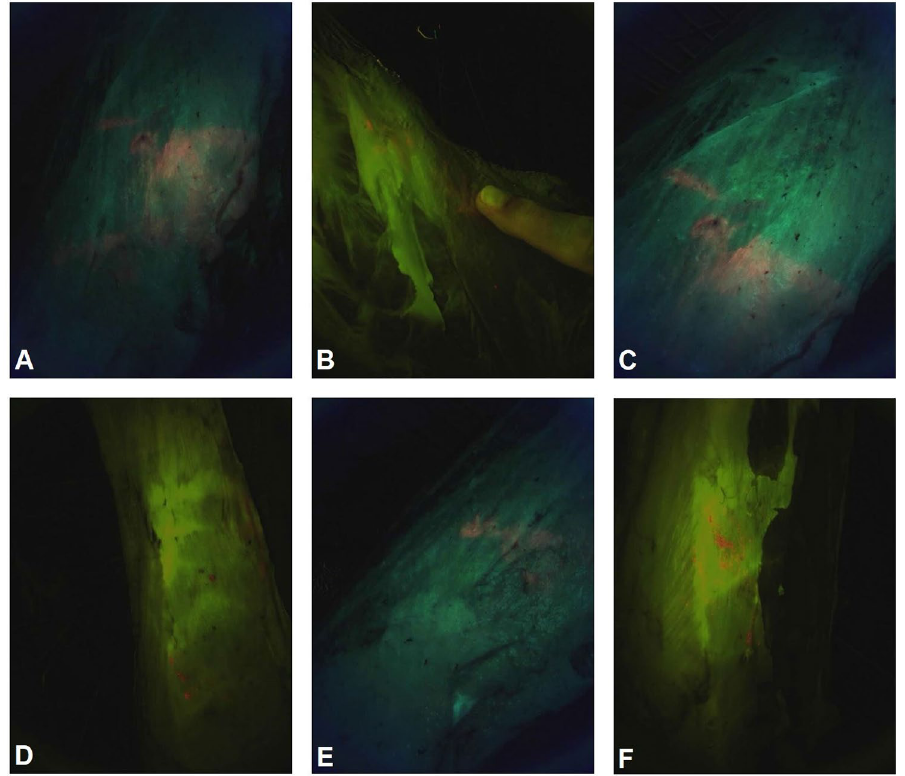
Figure 3. Six CSI-D fluorescence images of meat surfaces with fecal contamination ( A – F ).